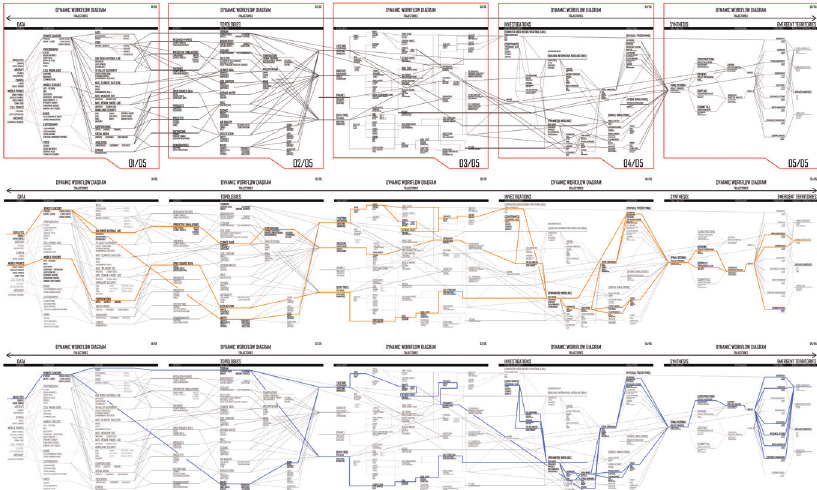
Figure 3: Preliminary proposal for a workflow diagram. Categories and connections are continuously subject to extension and modification based on predominant trends and emerging topics. Middle and bottom diagrams reflect its use referencing certain projects. Middle: PetaJakarta.org is a research project led by